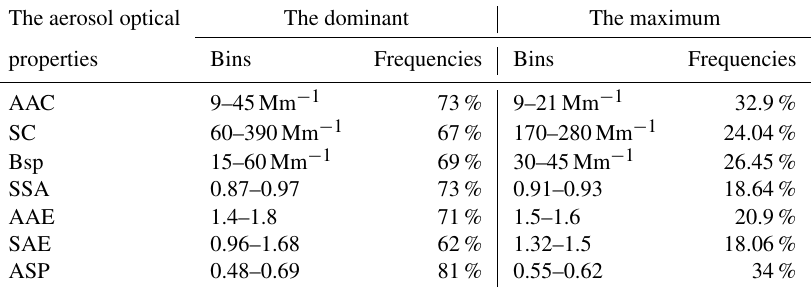
Table 3. The dominant and maximum frequencies as well as corresponding ranges of the aerosol optical properties. The aerosol optical The dominant The maximum